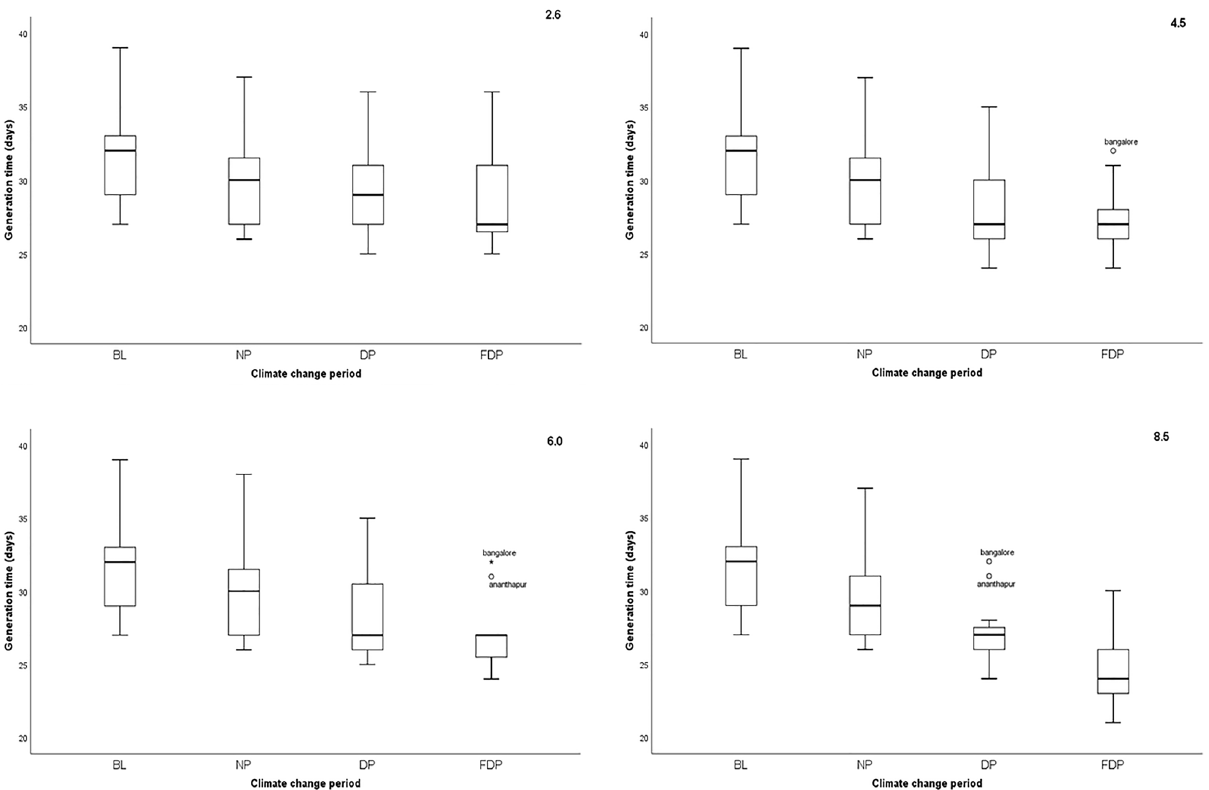
Figure 7. Trends in mean gen. time of H. armigera in Crop Season across 4 RCPs and 4